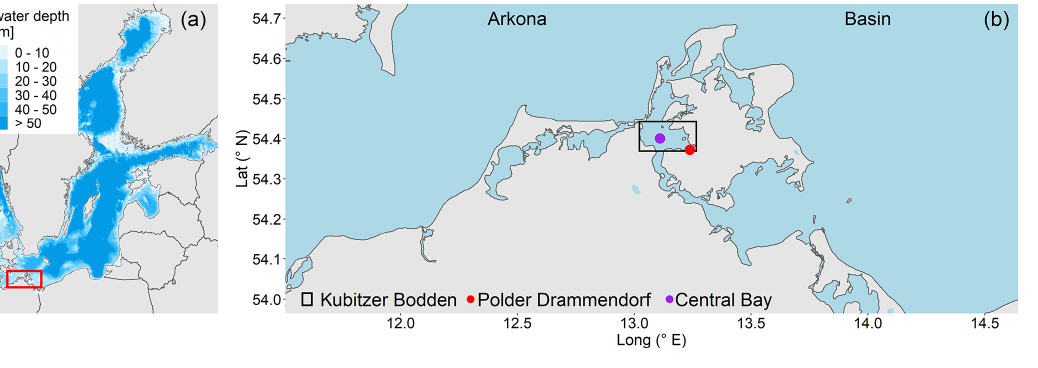
Figure 1. (a) Overview of the study area located in the southern Baltic Sea. (b) Coastline of northeastern Germany in Mecklenburg- Vorpommern and the study area location (Polder Drammendorf, in red) on the island of Rügen, bordering on the Kubitzer Bodden, where a monitoring station served as reference (central bay, in purple). The Kubitzer Bodden is connected with the Arkona Basin to the north. Bathymetry refers to Seifert et al. (2001), and borders were retrieved from National Oceanic And Atmospheric Administration (NOAA) and National Centers For Environmental Information (NCEI).